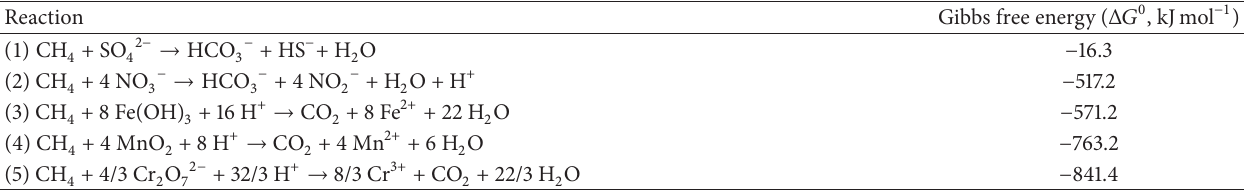
Table 1: Gibbs free energy changes under standard conditions ( Δ𝐺 0 ) for anaerobic methane oxidation coupled to different electron acceptors (possibly) performed by